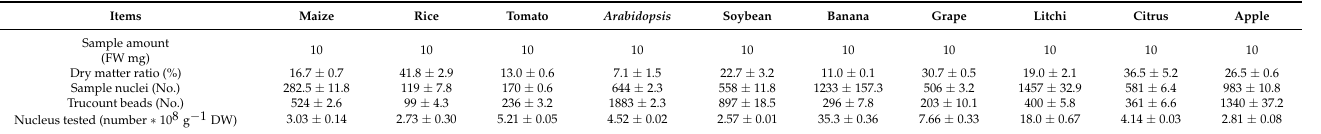
Table 2. Detailed statistical data of trucount beads, nuclei, dry weight for the leaves from ten plants.